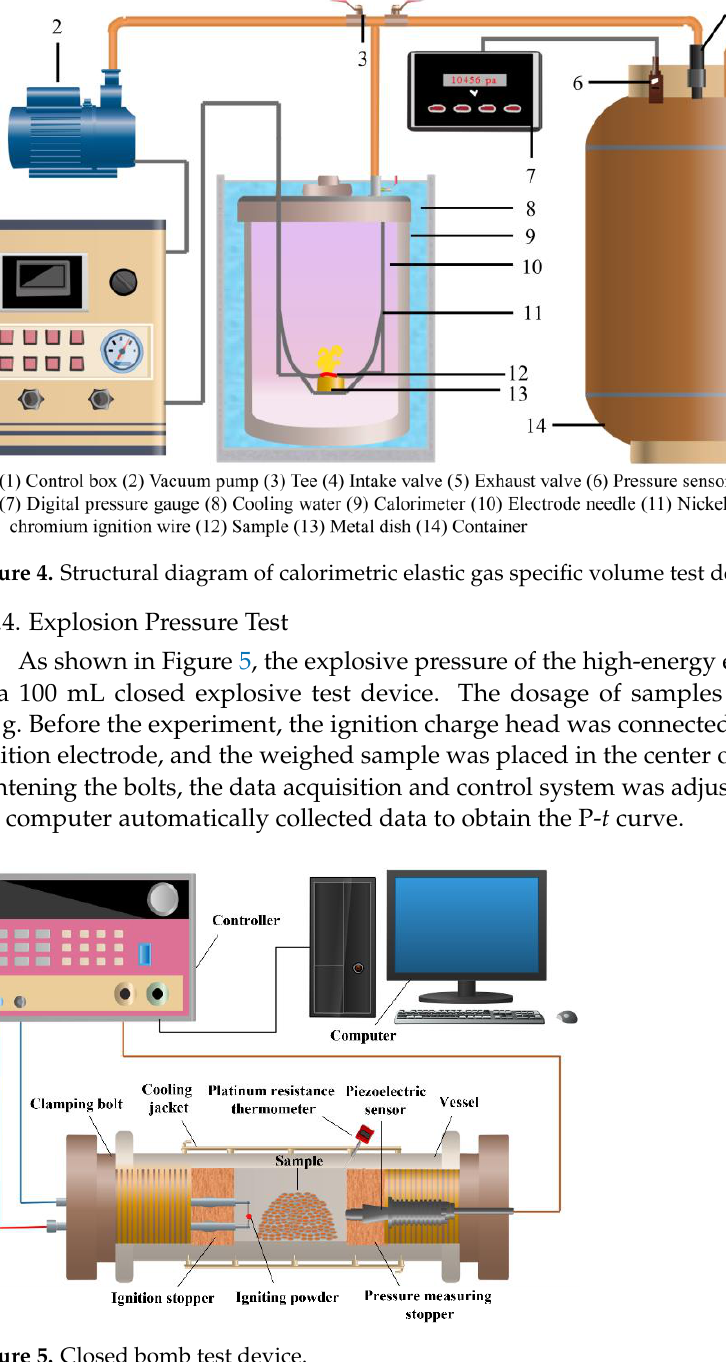
Figure 5. Closed bomb test device.